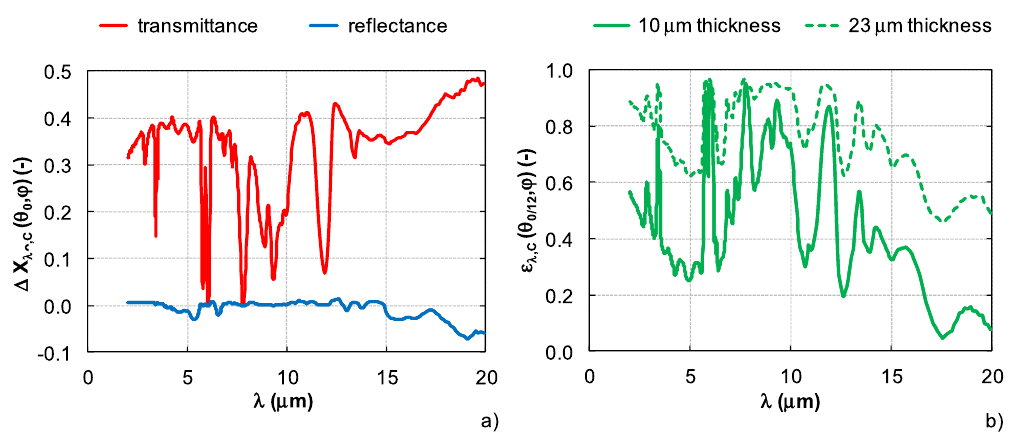
Figure 10. Differences of optical properties of semitransparent coating DupliColor Aerosol Art RAL 9500/ Ge substrate between coating thickness of 10 μ m and 23 μ m. ( a ) Absolute difference of transmittance and reflectance. ( b ) Emissivity for two different coating